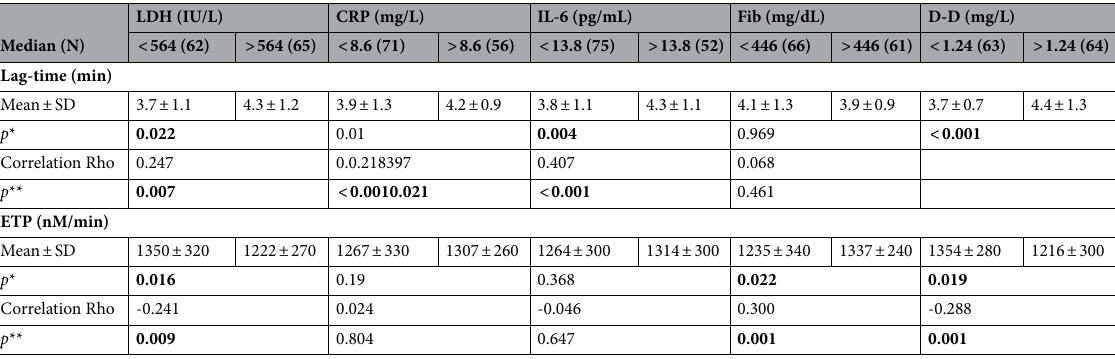
Table 5. Association between baseline TGA parameters (lag-time and ETP) induced by TF (5 pM) and peak analytical data in COVID-19 patients. Bold values denote statistical significance at the p < 0.05 level. Peak values of LDH, CRP, IL-6, Fib and D-D are dichotomized according to the median. *Mann–Whitney-U test and on **Spearman’s Rho correlations. Rho Spearman’s Rho (range: − 1.00 to + 1.00), ETP Endogenous thrombin potential, LDH Lactate dehydrogenase, CRP C reactive protein, IL Interleukin, O.D. optical density, Fib Fibrinogen, D-D D-dimer.